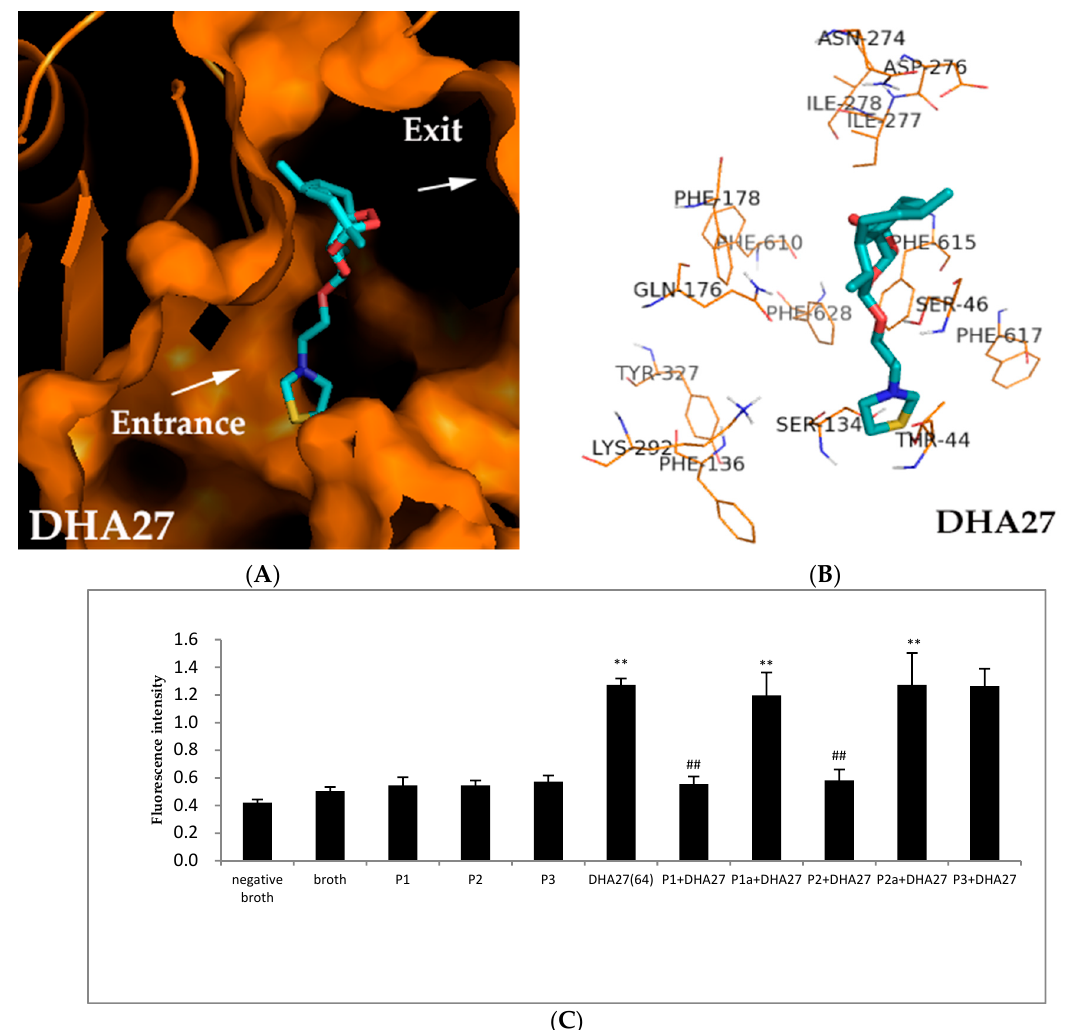
Figure 7. Molecule docking of DHA27 binding to AcrB. The crystal structure of AcrB (PDB ID, 2DRD) was obtained from Protein Data Bank. The molecular docking results were analyzed and represented in the PyMOL 1.3 visualization software. Proteins are shown in orange. The compound is shown as thick sticks colored according to the atom type (red, oxygen; cyan, carbon; white, hydrogen; dark blue, nitrogen, khaki, sulfur), and residues are shown in bluish violet and marked. ( A ) Longitudinal section of substrate translocation pathway when DHA27 was docked with AcrB when PDB ID 2DRD was used; ( B ) Cartoon view of DHA27 docked with AcrB when PDB ID 2DRD was used; ( C ) Effect of DHA27 on binding polypeptides from AcrB and its mutant peptides. Daunorubicin accumulation within E. coli ATCC 35218 pretreated with DHA27 and polypeptides; 64 mg/L of DHA27 and polypeptide (molar ratio: 1:1) were cultured for 30 min at 37 °C. This mixture was added to the E. coli concentrations of 1.0 × 10 6 cfu/mL and cultured for 6 h at 37 °C in a heated and shaking environmental chamber. The bacterial pellet was resuspended, and the bacterial suspension was adjusted to an OD 600 of 1.0. After co-culture with daunorubicin (40 mg/L) in the dark at 37 °C for 30 min, the bacteria were centrifuged at 3000 rpm for 5 min to harvest the bacterial pellet. After washing with PBS (0.2 mM, pH 7.2) five times, fluorospectrophotometry was used to observe daunorubicin accumulation within E. coli. The emission wavelength was 467 nm, and the excitation wavelength was 588 nm. ** p < 0.01 compared with broth; ## p < 0.01 compared with DHA27.